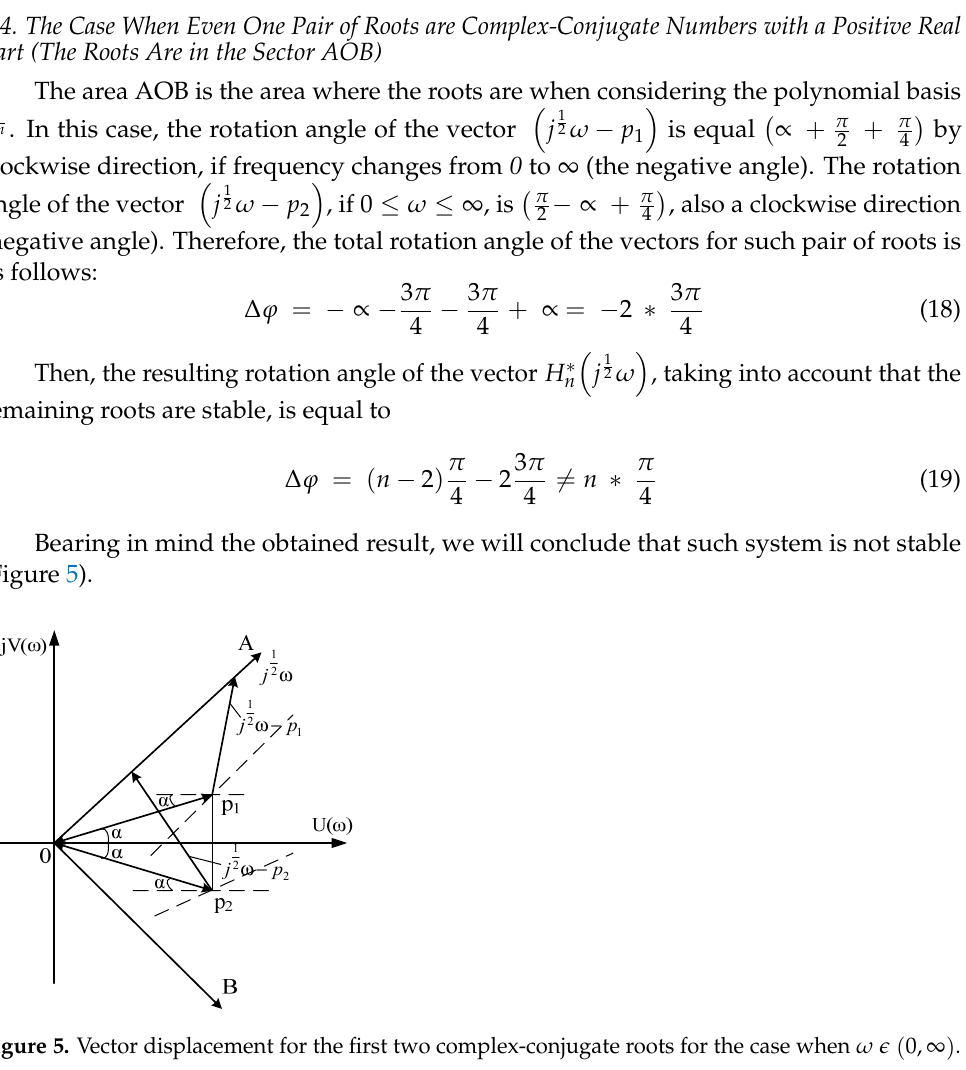
Figure 6. The transition function in this case. The obtained result indicates that this system is not stable. At the same way is indicated the value ∆φ , which was calculated for this case of the poles’ location on the complex plane. 2.5. The Case of Complex-Conjugate Roots with a Positive Real Part (The Roots Are Outside the Sector AOB)